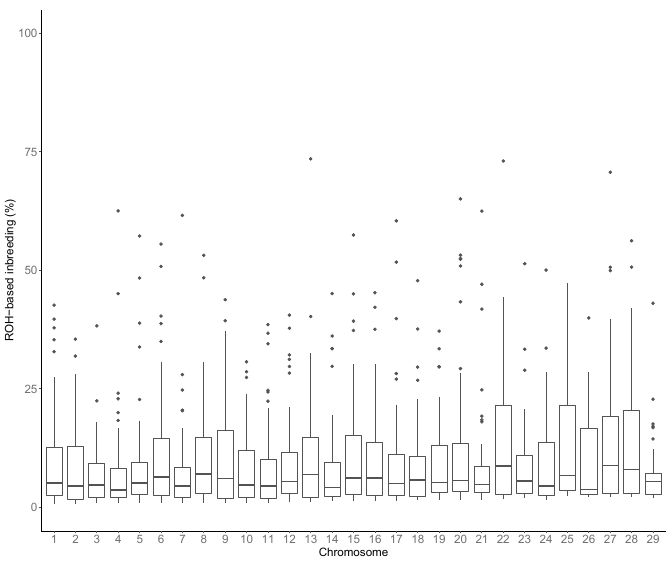
Figure 4. Runs of homozygosity (ROH) based inbreeding in each considered autosome. Table 4. Pearson’s correlations (above diagonal) among genomic ( F GRM ), pedigree ( F PED ) and Runs of Homozygosity ( F ROH ) based inbreeding coefficients, significance values 1 are reported below the